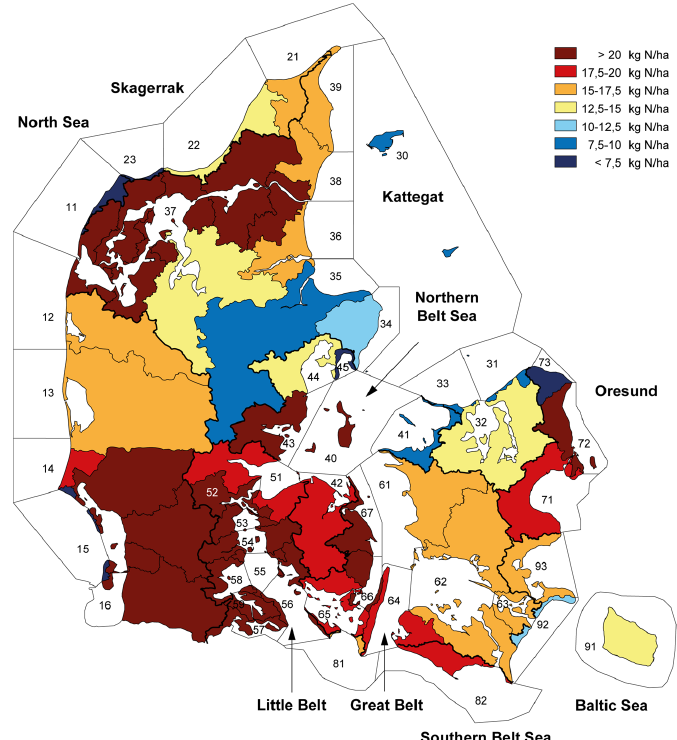
Figure 4. Total Nitrogen loads (kg ha − 1 ) from Danish catchments to coastal waters in 2015. [7,19,32].